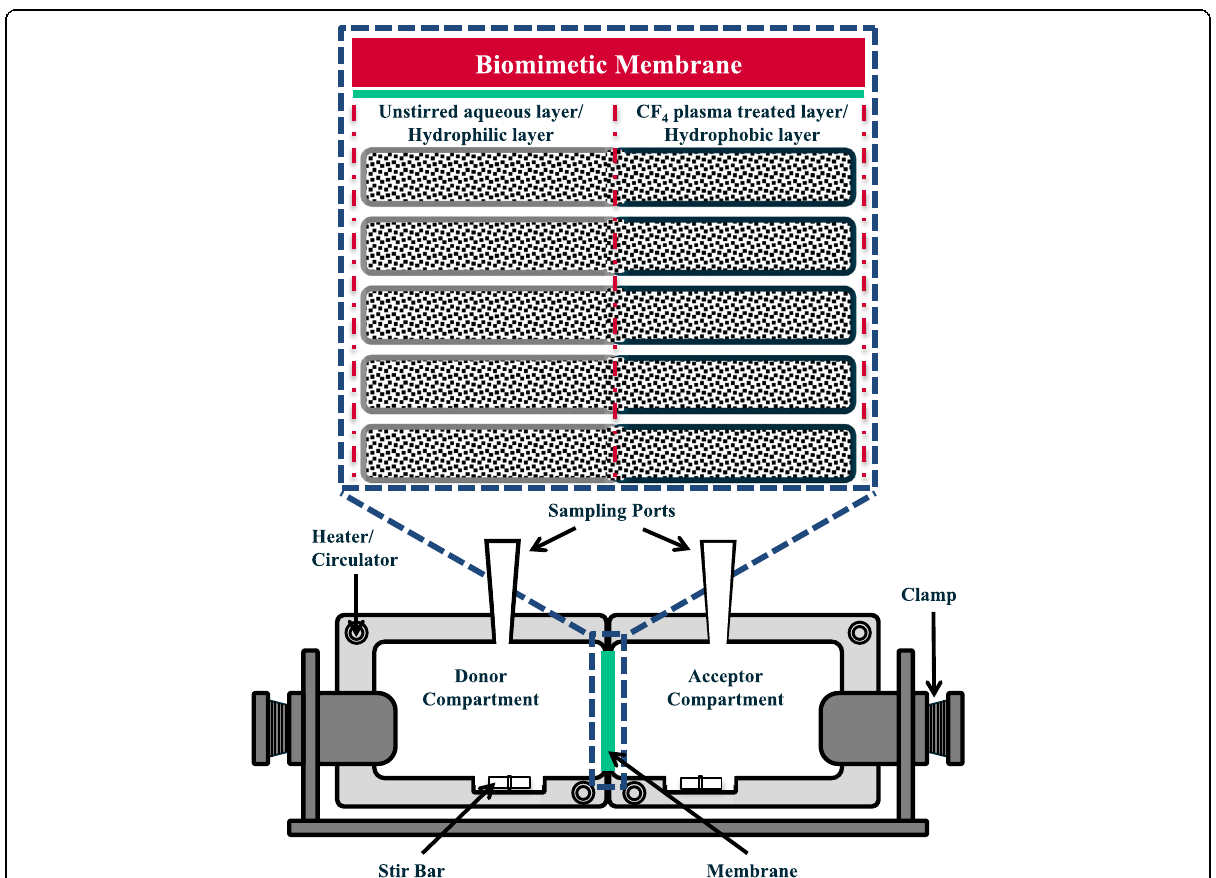
Fig. 1 Schematic illustration of a biomimetic membrane and the membrane-permeation dissolution